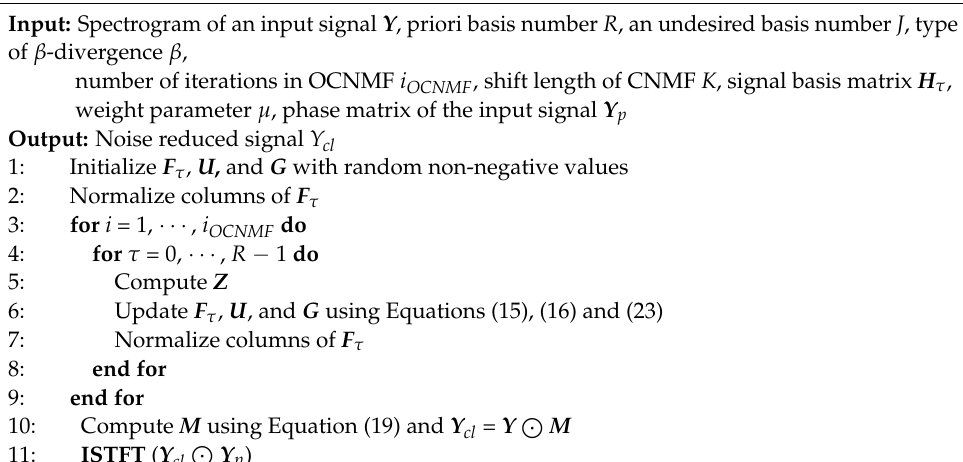
Algorithm 2. Noise analysis and reduction using